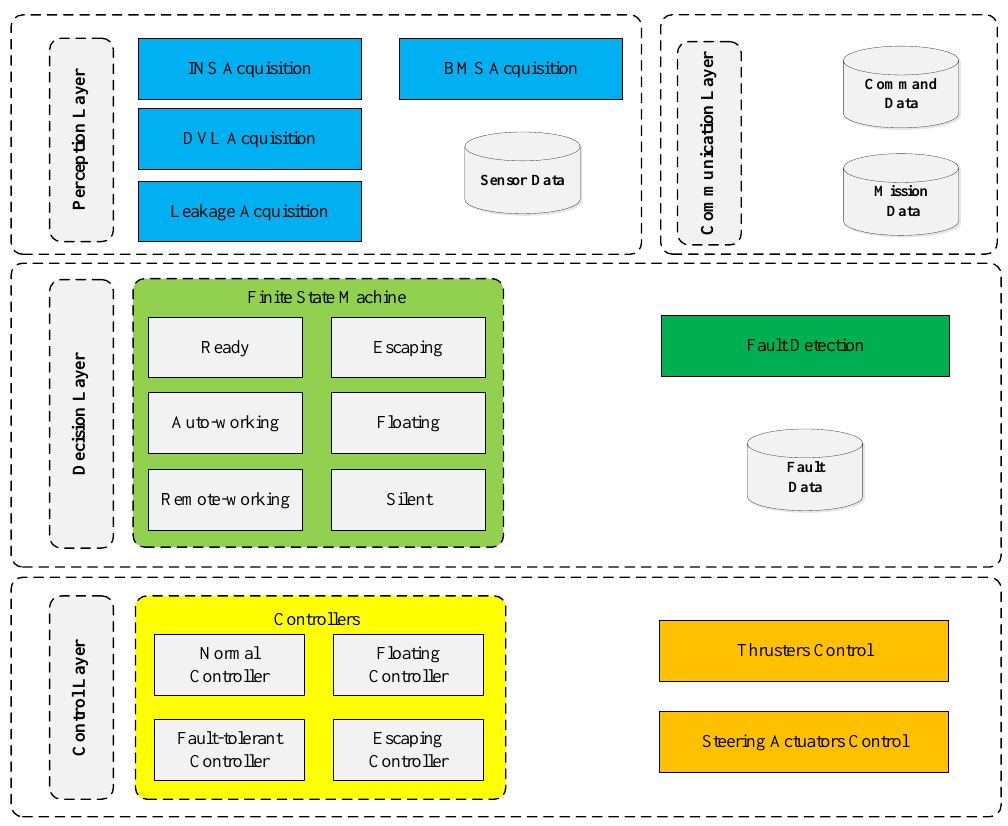
Figure 5 . Architecture of FSM-based onboard software. Figure 5. Architecture of FSM-based onboard